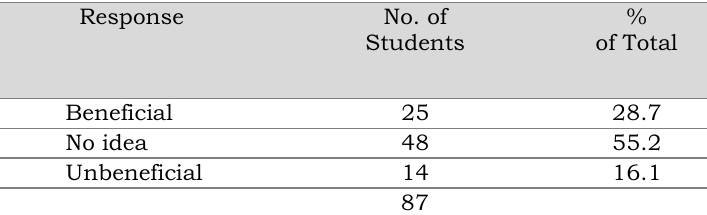
Table 1. Seemingly cool response to FbG as learning media